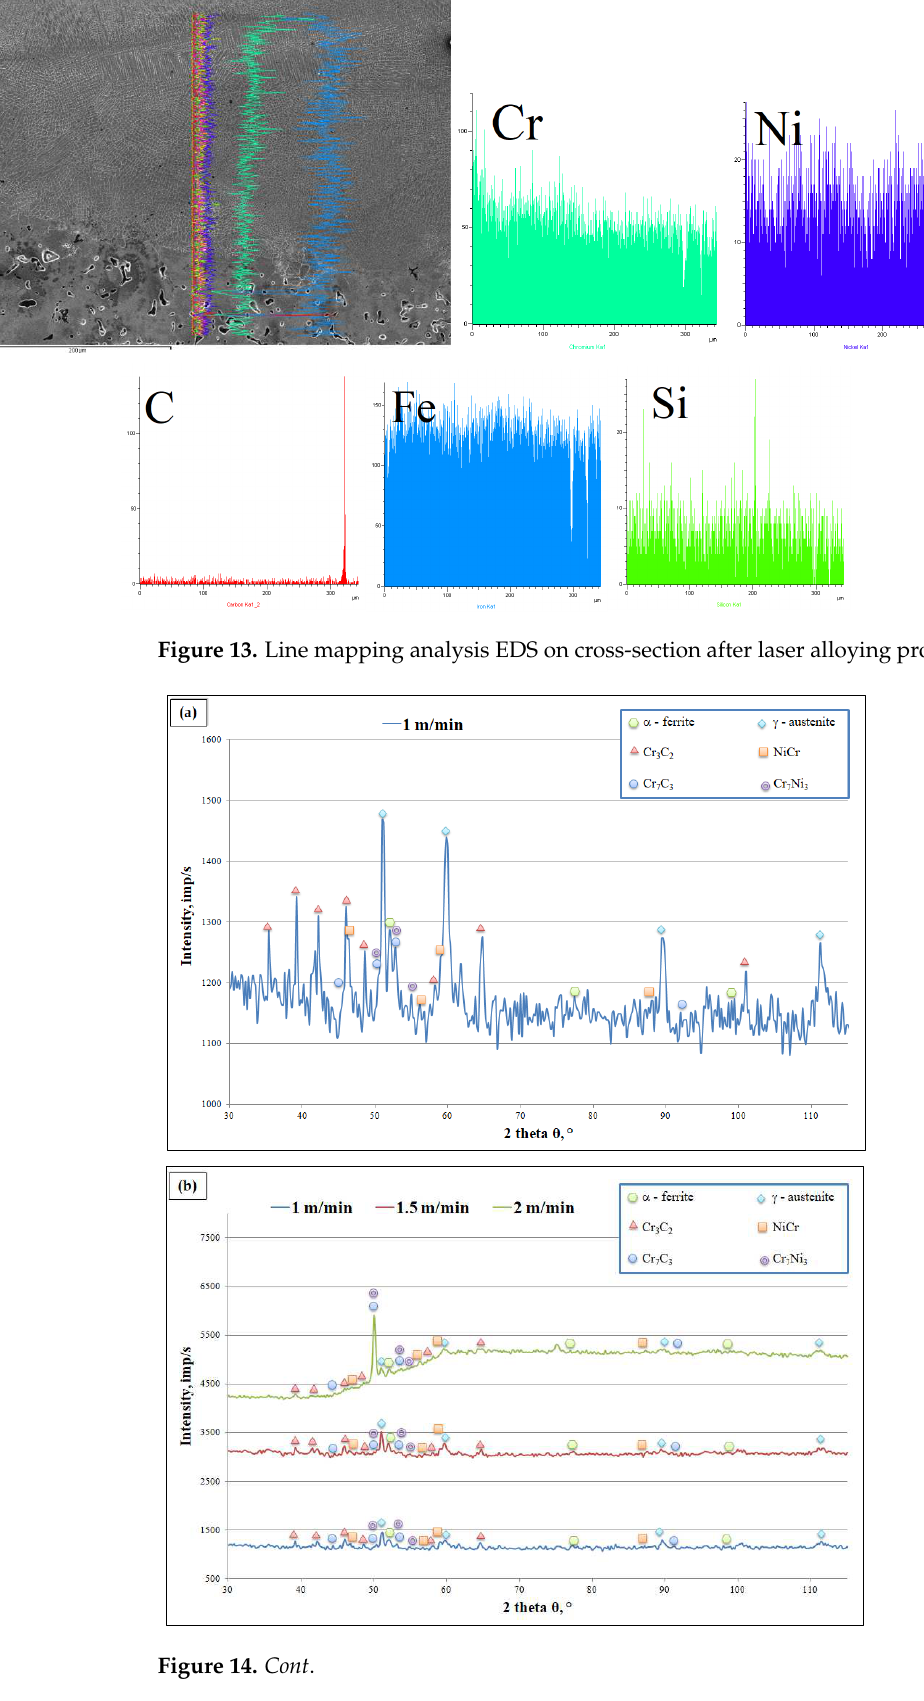
Figure 12. Line mapping analysis EDS on cross-section after laser alloying process for sample 2.